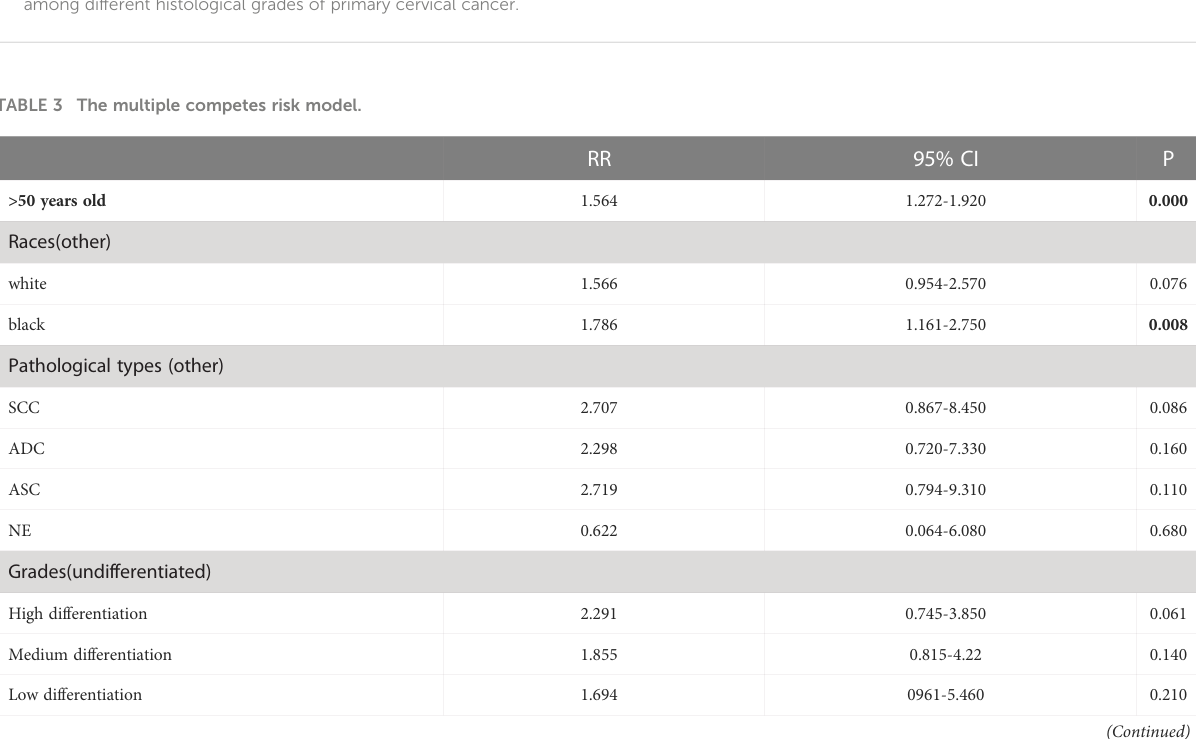
FIGURE 8 The comparison of cumulative incidences of SPM. (A) The comparison between age older than 50 years old and younger than 50 years old; (B) The comparison between the patients receiving surgery or not; (C) The comparison among different stages; (D) The comparison among different pathological types of primary cervical cancer; (E) The comparison among different methods of radiotherapies; (F) The comparison among different histological grades of primary cervical cancer.